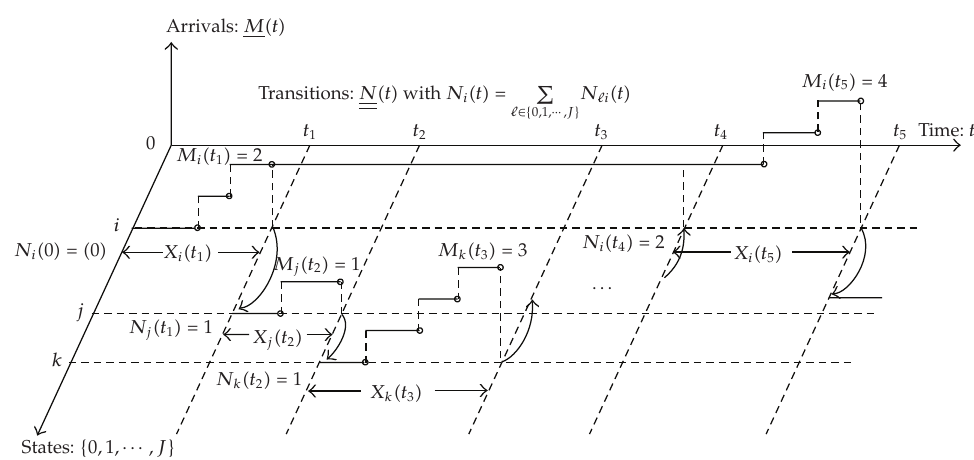
Figure 2: Typical sample path of (cid:6) M (cid:3) t (cid:4) ,N (cid:3) t (cid:4)(cid:7)